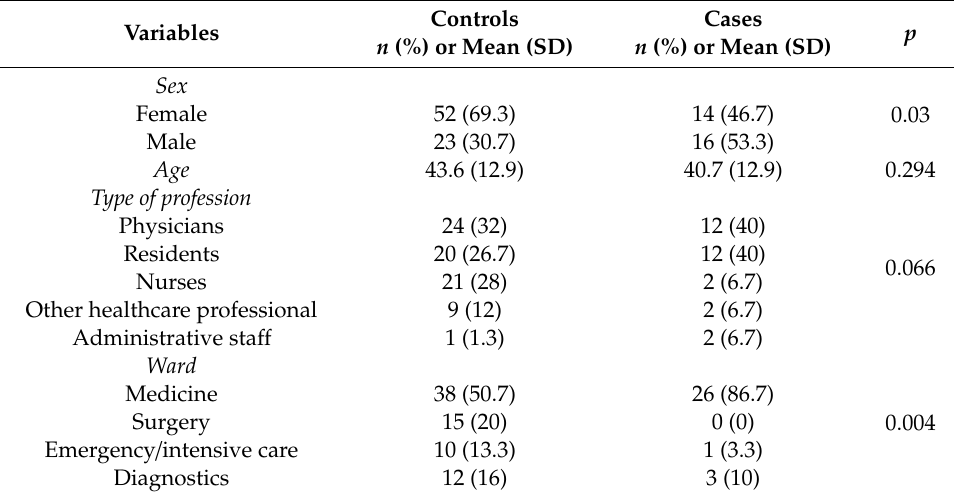
Table 1. Characteristics of the study